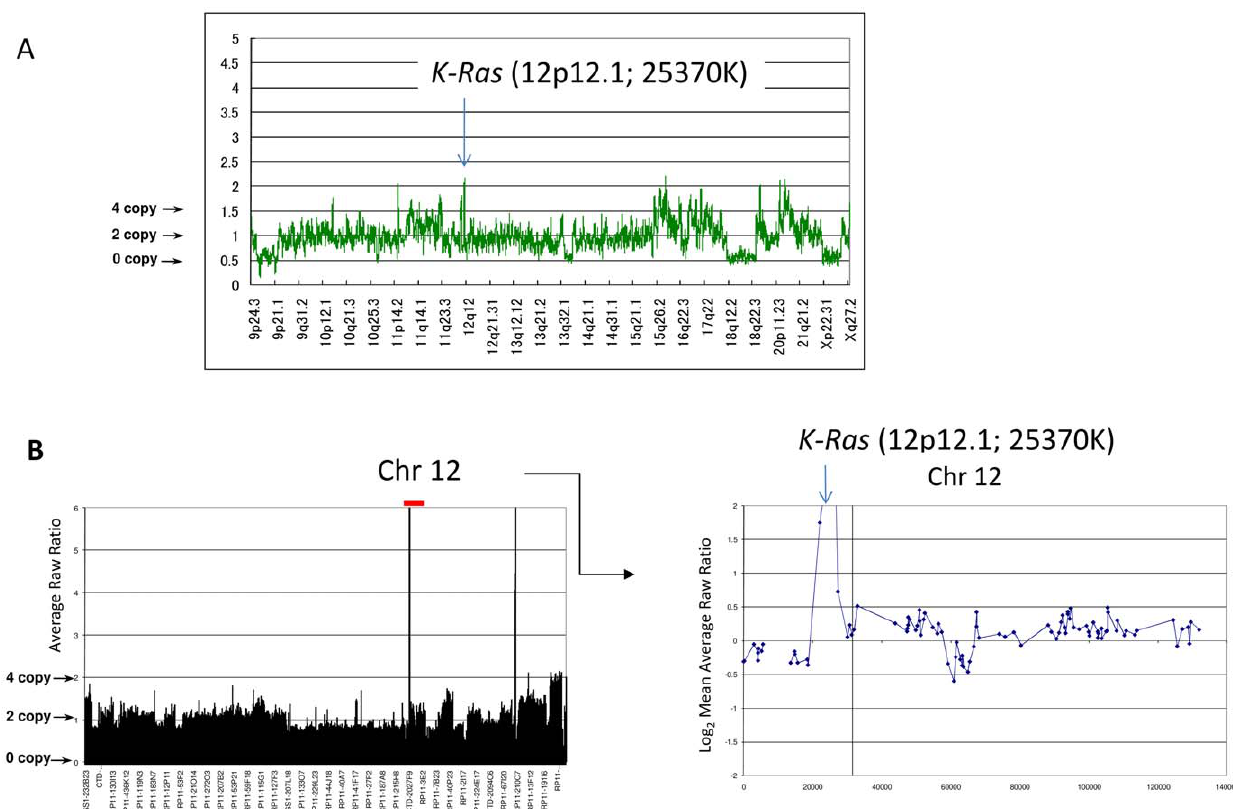
Figure 1. Copy number gain at the locus of K-Ras (12p12.1) in the two group D cell lines. (A) SNP array ‘karyograms’ (250K) of HEC-50B cells. The graph shows the total copy number through chromosome 9p-X. The locus of K-Ras is amplified as indicated. (B) Array CGH of KLE cells. The graphs show total copy number throughout the entire genome (Left) and chromosome 12 (Right). The locus of K-Ras is amplified as indicated.